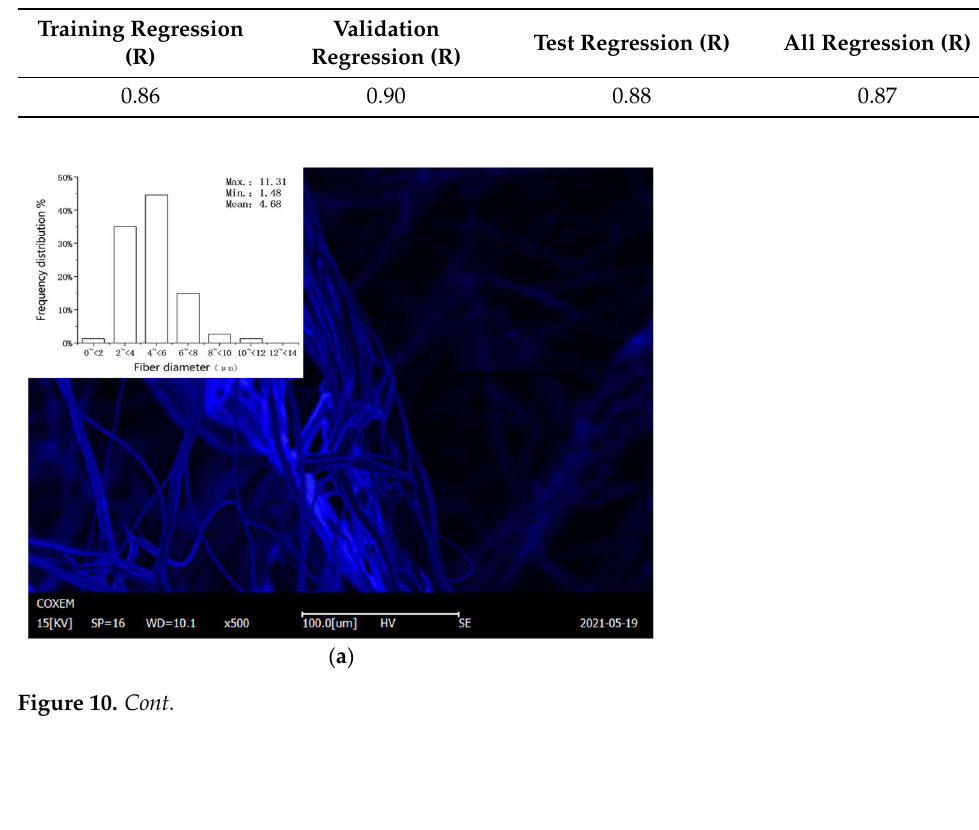
Figure 9. ( a ) The DOP particles and NaCl particles filtration efficiency at 80 °C for 0. 75 h and 24 h, respectively. ( b ) The DOP and NaCl particle filtration efficiency at 90 °C for 0. 75 h and 24 h, respec-